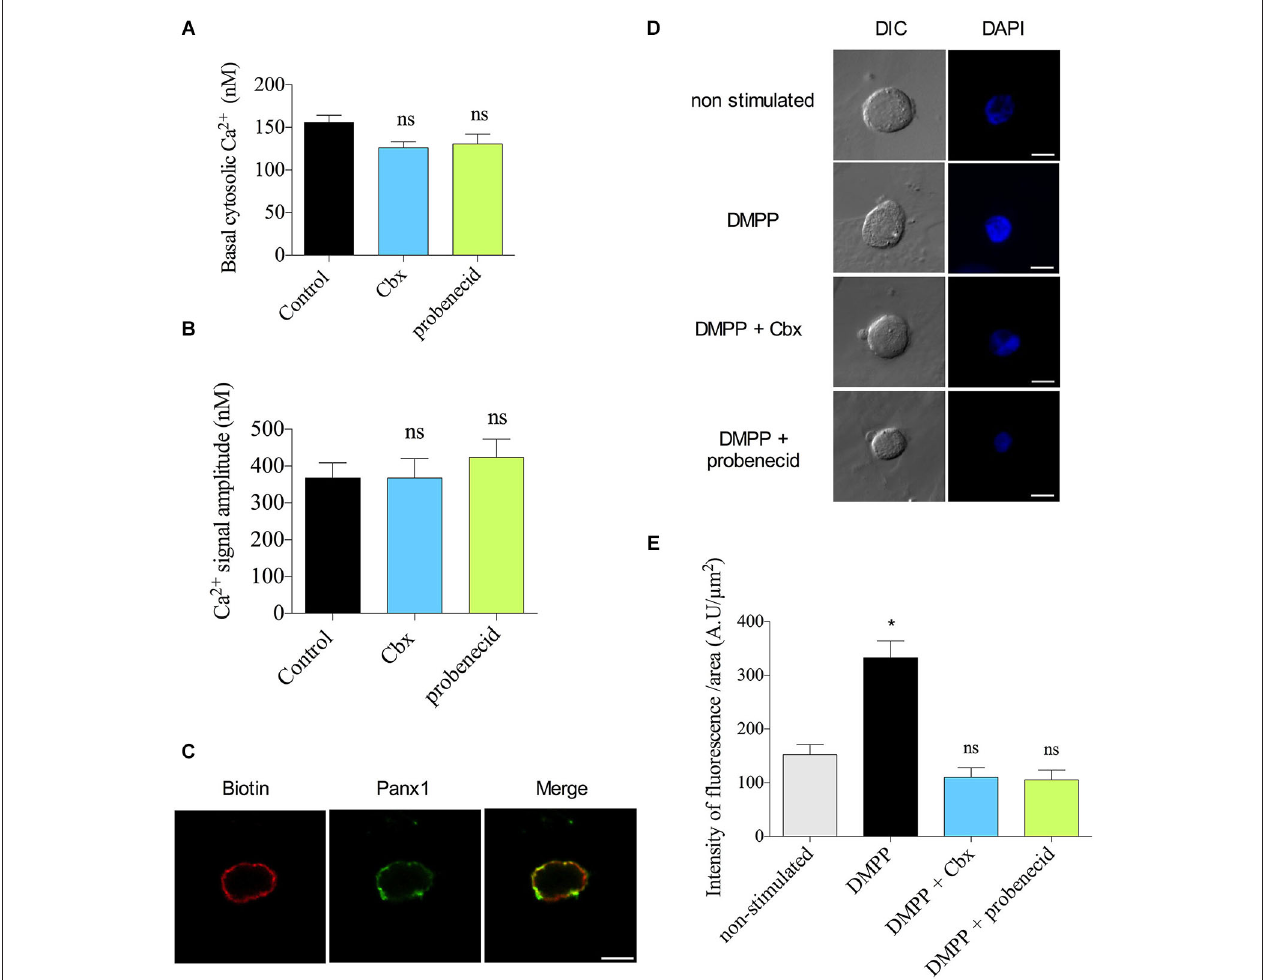
visualized with DAPI staining. Scale bar = 10 µ m. (D,E) DAPI uptake experiments were performed incubating the cells for 10 s in a Kreb’s HEPES solution containing 50 µ M DAPI without (unstimulated cells) or with nicotinic agonist receptor DMPP (50 µ M). Then cells were incubated with Kreb’s HEPES solution containing 50 µ M DAPI for 2 min and immediately fixed with 4% PFA (in PBS, pH 7.4). After 3 washes with PBS (pH 7.4), coverslip were mounted for visualization. Treatment with probenecid (200 µ M) Cbx (5 µ M) were performed 15 min before the experiments and the inhibitors were maintained in the bath solution until cell fixation. (D) Confocal imaging and (E) quantification of DAPI uptake in unstimulated ( n = 24) or DMPP stimulated cells, nontreated ( n = 21) or treated with the Panx channel inhibitors ( n = 24 and n = 19 for probenecid and Cbx respectively). Scale bar = 10 µ m. Data shows mean ± SEM of